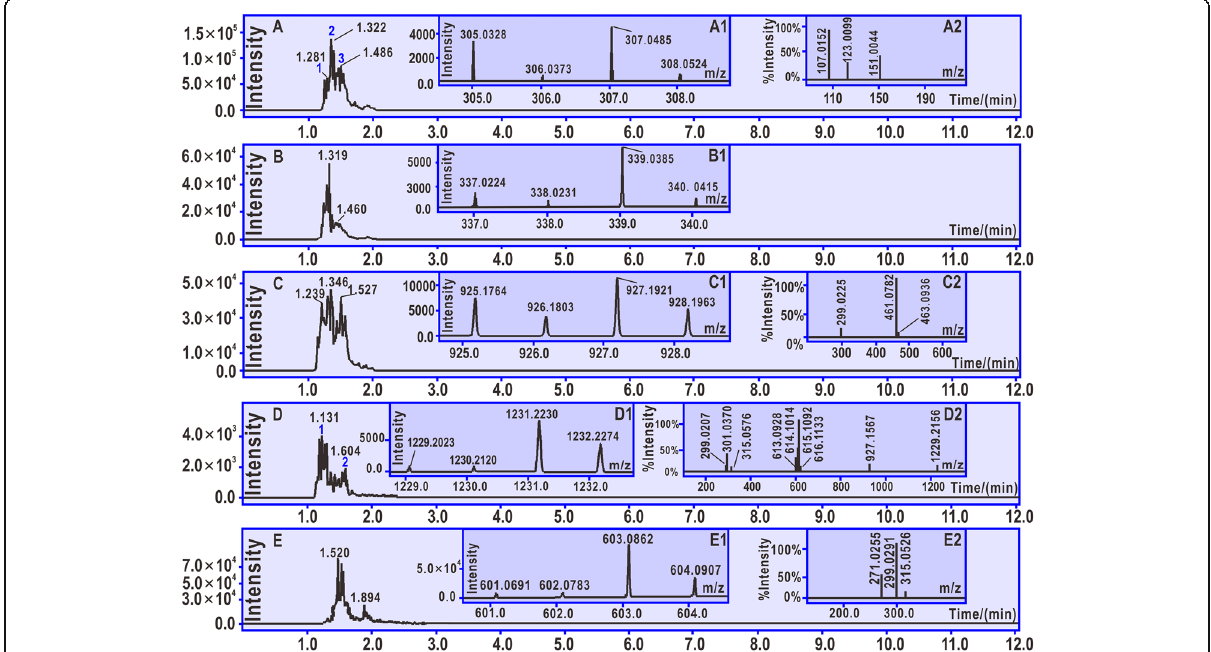
Fig. 4 Results of UPLC-ESI-Q-TOF-MS/MS analysis. a Chromatogram of proto catechuic acid-protocatechuic acid dimer after the extraction of [C 14 H 10 O 8 -H] − .a1 Primary MS spectra of protocatechuic acid-protocatechuic acid dimer. a2 Secondary MS spectra of protocatechuic acid- protocatechuic acid dimer. b Chromatogram of gallic acid-gallic acid dimer after the extraction of [C 14 H 10 O 10 -H] − . (B1) Primary MS spectra of gallic acid-gallic acid dimer. c Chromatogram of hyperoside-hyperoside dimer after the extraction of [C 42 H 38 O 24 -H] − . c1 Primary MS spectra of hyperoside- hyperoside dimer. c2 Secondary MS spectra of hyperoside-hyperoside dimer. d Chromatogram of 2 ′′ -O-galloylhyperin-2 ′′ -O-galloylhyperin dimer after the extraction of [C 56 H 46 O 32 -H] − . d1 Primary MS spectra of 2 ′′ -O-galloylhyperin-2 ′′ -O-galloylhyperin dimer. d2 Secondary MS spectra of 2 ′′ -O-